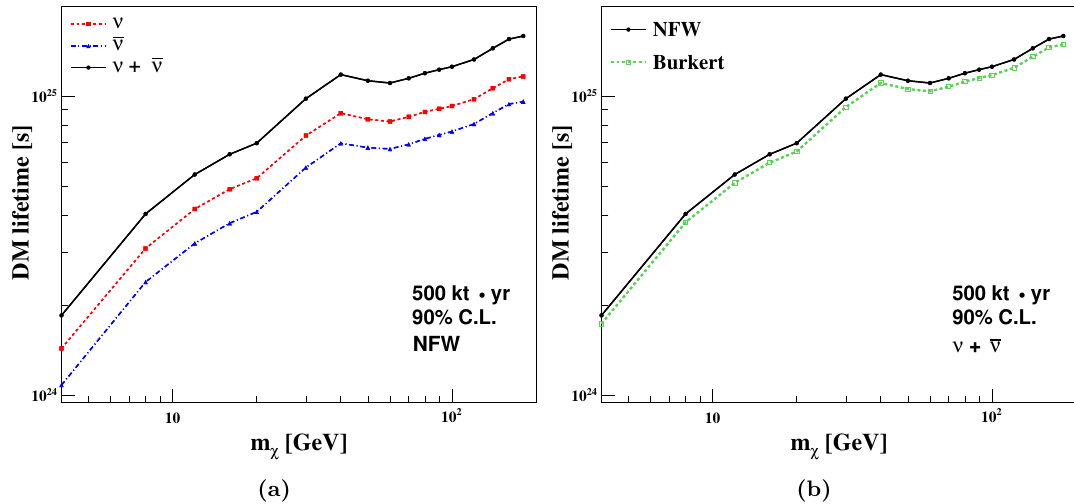
Figure 7. (a) The lower bound on the decay lifetime of dark matter ( (cid:31) ! (cid:23) (cid:22) (cid:23) ) as a function of DM mass m (cid:31) at 90% C.L. (1 d.o.f.) obtained using only (cid:23) (cid:22) and only (cid:22) (cid:23) (cid:22) data using 500 kt (cid:1) yr exposure of MagICAL. The red dashed (blue dot-dashed) line shows the sensitivity coming from (cid:23) (cid:22) ((cid:22) (cid:23) (cid:22) )-induced events. The black solid line represents the same combining (cid:23) (cid:22) and (cid:22) (cid:23) (cid:22) events